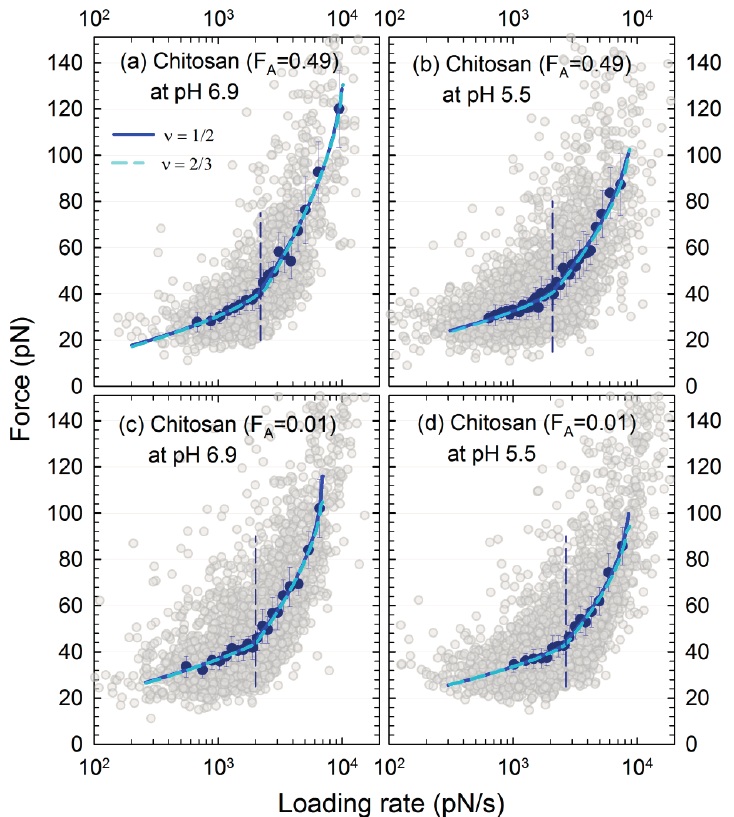
Figure 5. Force spectroscopy analysis of mucin–chitosan forced unbinding data for chitosans with F A = 0.01 and 0.49, and at pH 5.5 (25 mM acetate buffer, 150 mM NaCl) and 6.9 (25 mM Hepes buffer, 150 mM NaCl) aqueous buffer. The data is presented as individual dissociation events (transparent symbols for each unbinding event) and mean rupture force versus loading rate (blue symbols) in the sub-distribution,